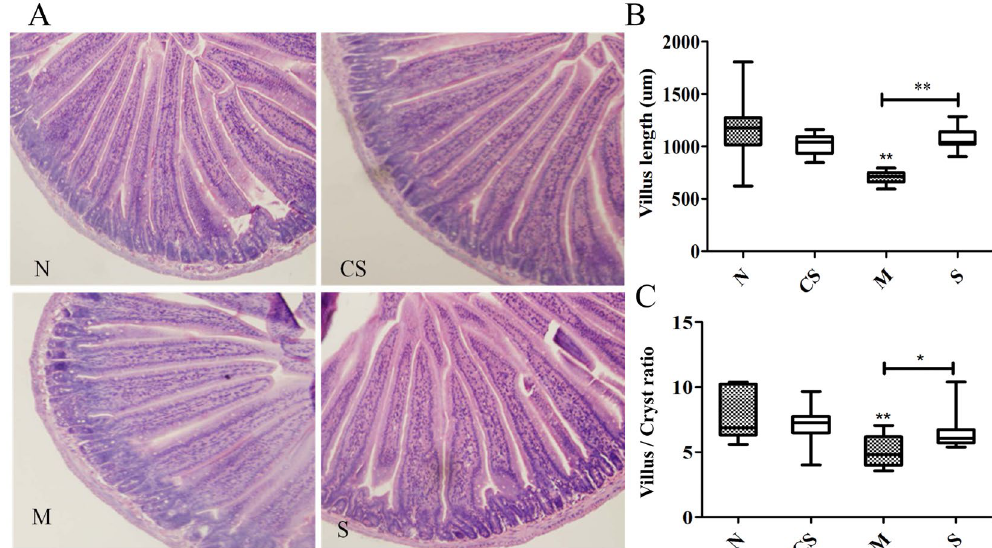
Figure 2. Intestinal morphology and structure of the mice after the 16-day experimental period. ( A ) Ileum morphology; ( B ) Villus length; ( C ) Villus/Cryst ratio. N: healthy mice + PBS; CS: healthy mice supplemented with a daily dose of 150 mg/kg bodyweight of CS disaccharides for 16 days; M: mice subjected to exhaustive exercise stress + PBS; S: the stressed mice supplemented with a daily dose of 150 mg/kg bodyweight of CS disaccharides for 16 days. * P < 0.05; ** P <